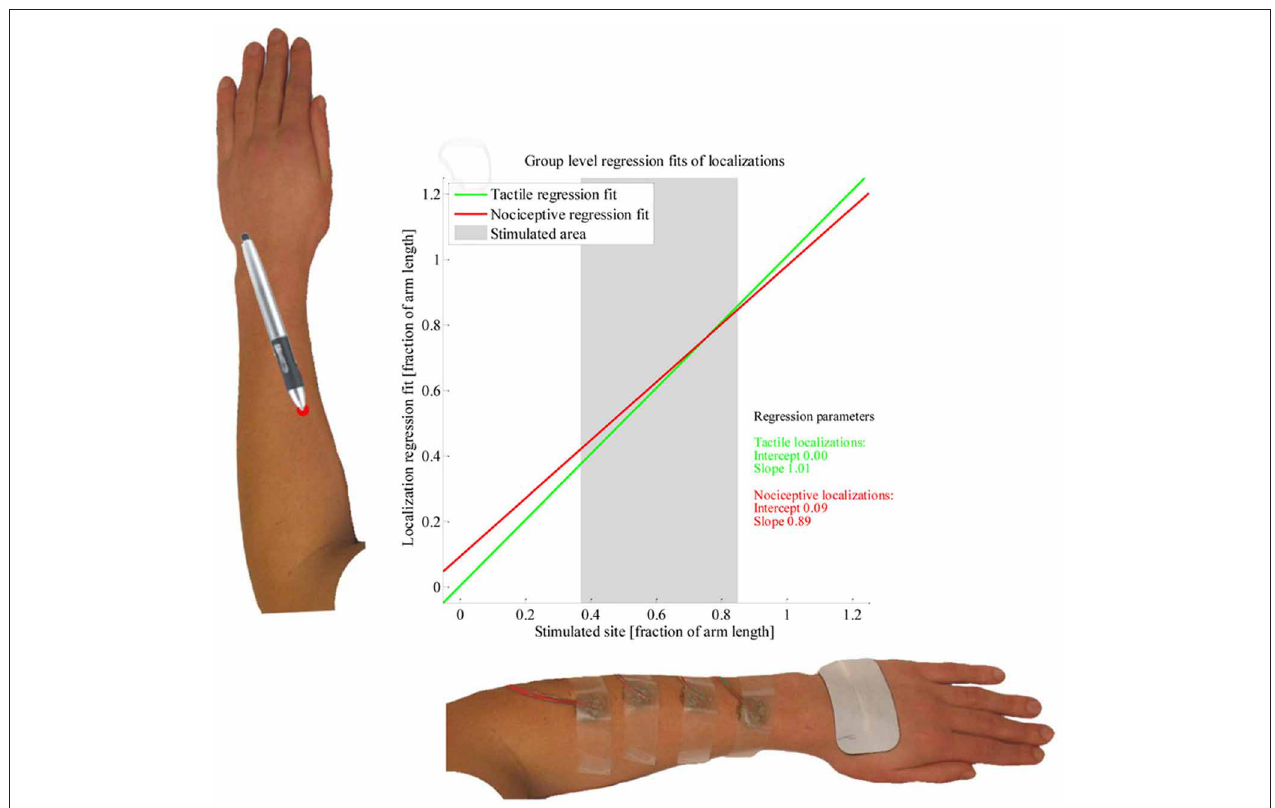
FIGURE 5 | Linear mixed model fit of the localization data. The two lines present the group-level regression fits of the tactile (green) and nociceptive (red) localizations; the regression parameters are presented